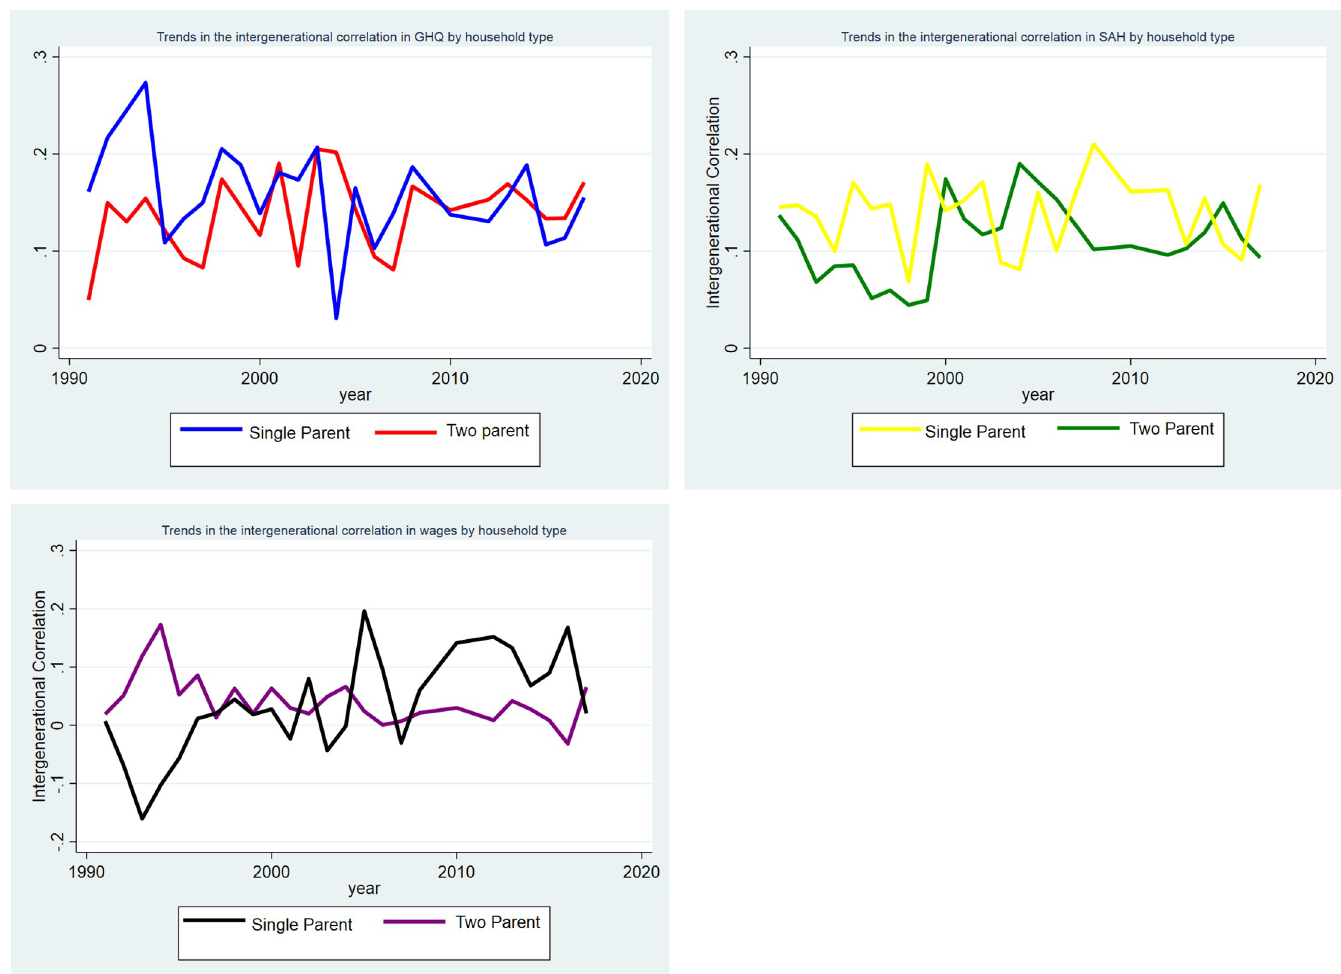
Fig 5. A: Trends in the intergenerational correlation in GHQ between 1991–2017 by single vs two parent household. B: Trends in the intergenerational correlation in SAH between 1991–2017 by single vs two parent household. C: Trends in the intergenerational correlation in log of hourly wages between 1991–2017 by single vs two parent household.